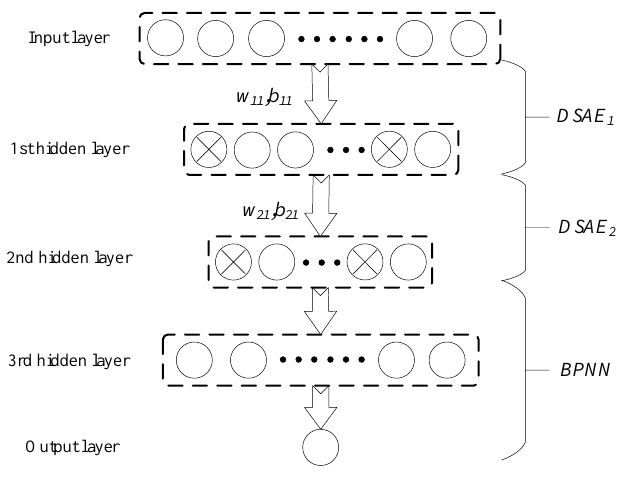
Figure 12. Diagram of SDSAE-BP network.